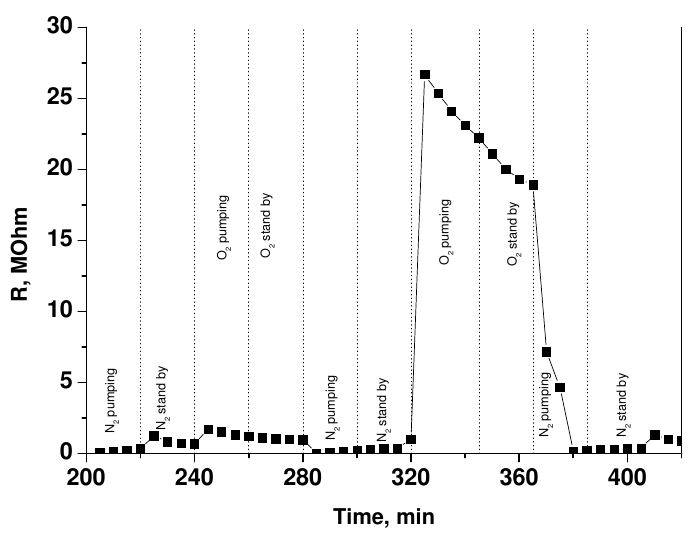
Fig. 6 YSZ Dependence of the resistance of pure YSZ in an atmosphere of different oxygen concentrations at 1090 K measured during the second day of the experiment. The sample is obtained by spray pyrolysis and is the same as that in Fig.